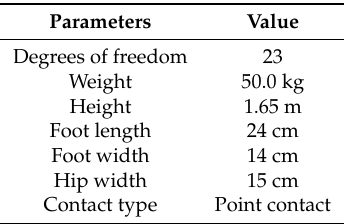
Table 1. We also present some comparisons between two different walking speeds. Through comparing different walking speeds, we can determine the function of the proposed gait planning method. Table 1. Parameters of robot BHR-6.